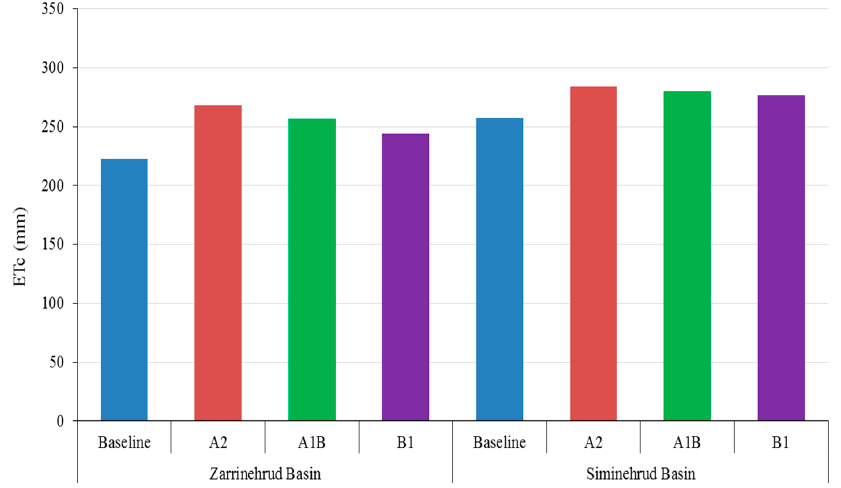
Figure 8. Comparison of mean actual evapotranspiration (ETc) in the future period (2015–2040) under different emission scenarios as compared to the baseline period (1986–2010).